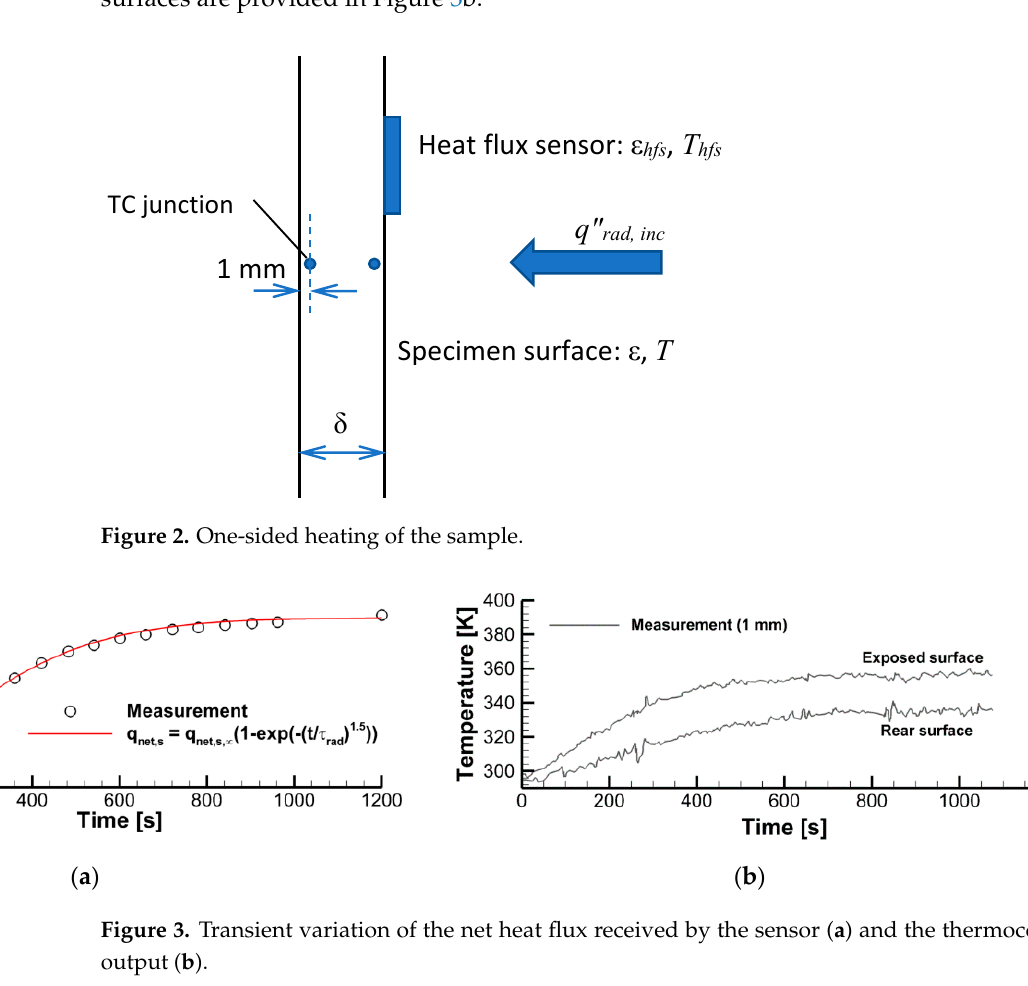
Figure 1. Experimental observation of the downward flame spread over the vertical polyurethane slab. Left to right : side view of the established propagating flame (horizontal lines are placed at a distance of 1 cm); front and side view of the extinguished specimen.